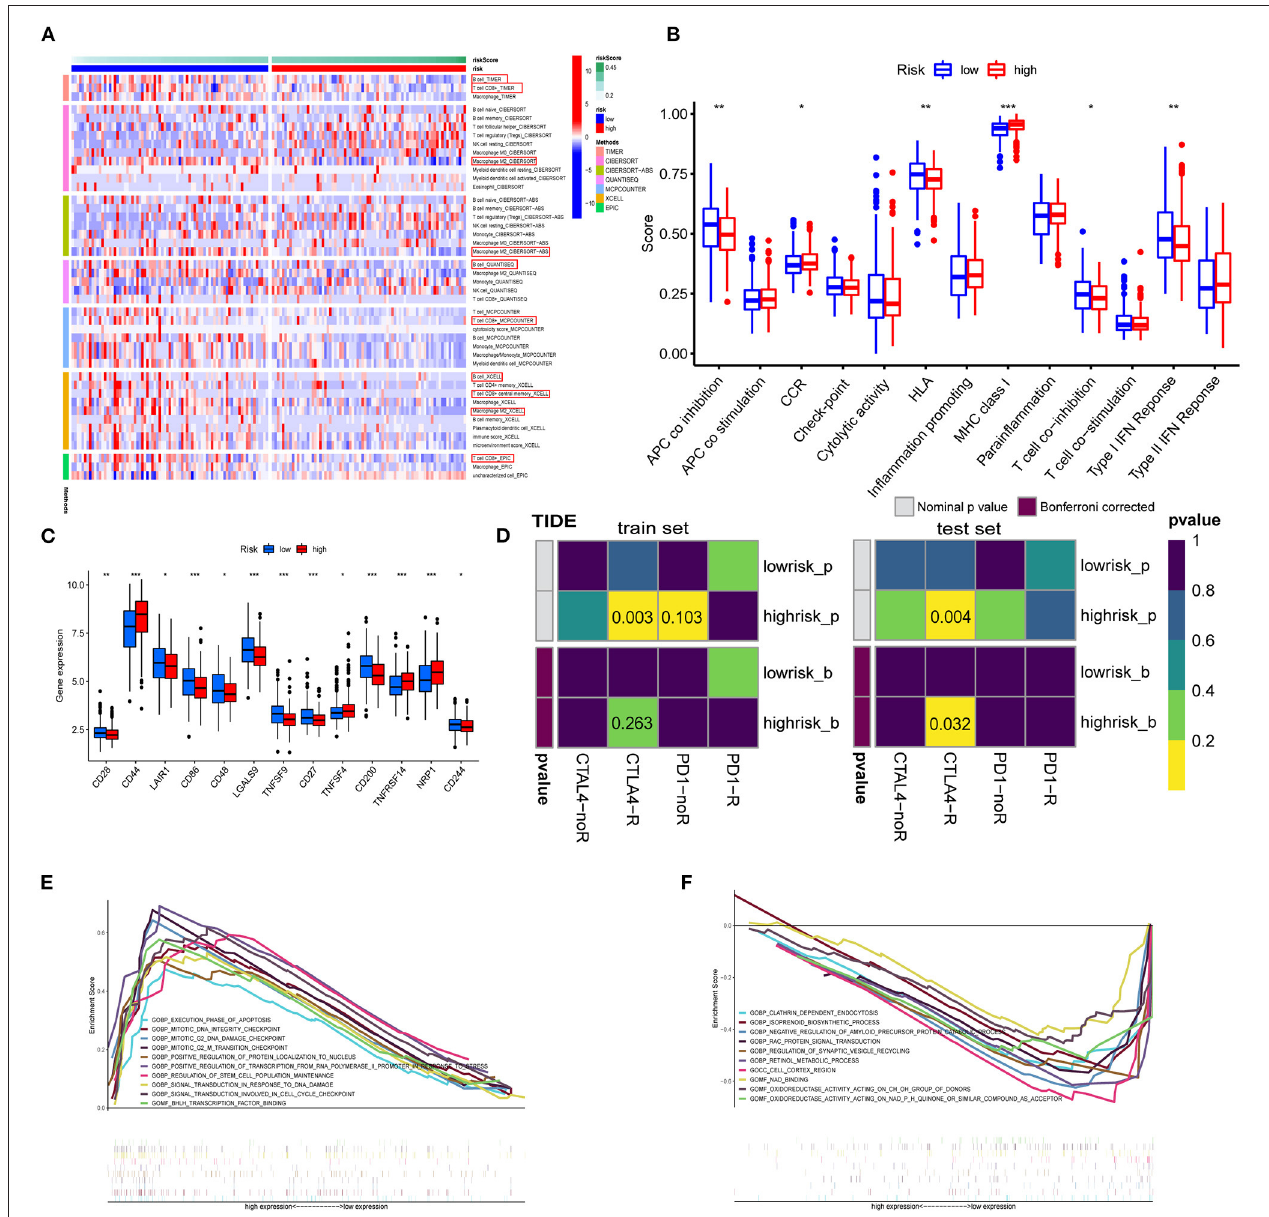
FIGURE 9 | Enrichment analysis of immune-related functions. (A) The TIMER, CIBERSORT, CIBERSORT.ABS, QUANTISEQ, MCPCOUNTER, XCELL, and EPIC algorithms were applied for the immune infiltration of the high- and low-risk groups. (B) Immune score estimated by single sample GSEA (ssGSEA) in different groups. (C) Immune checkpoints in the tumor microenvironment. (D) TIDE prediction of the association of genes prognostic signature with ICB responsiveness in train and test sets. (E,F) GO analysis for high-risk group (E) and low-risk group (F) using GSEA 4.1.0.